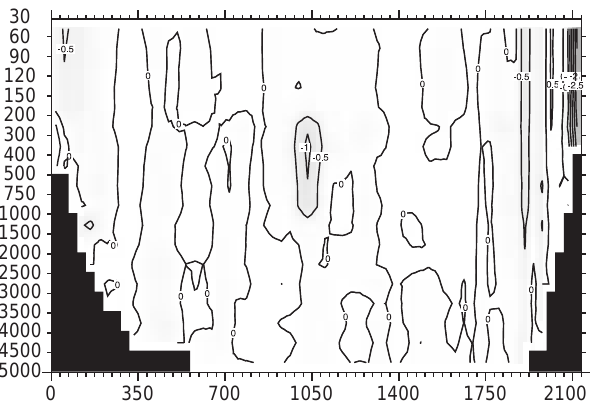
Fig. 8. An ‘‘optimal’’ estimate of the along-section geostrophic velocity component of the mean Weddell Gyre state. Regions of westward currents are shaded . Contour interval